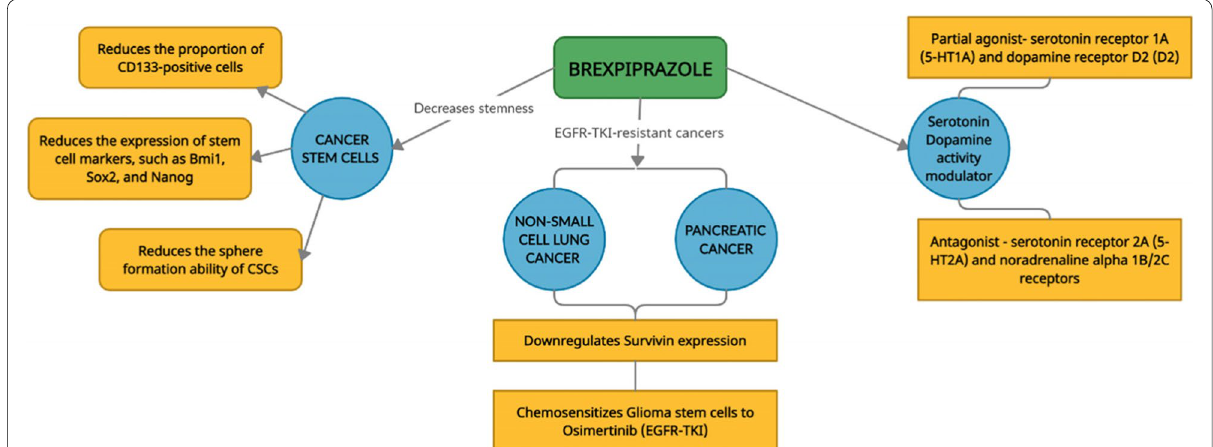
Fig. 1 Mechanism of action of Brexpiprazole in cancer. Brexpiprazole modulates the activity of serotonin and dopamine; downregulates expression of CD133 cells, Bmi1, Nanog, and Sox2; and reduces sphere formation ability of +